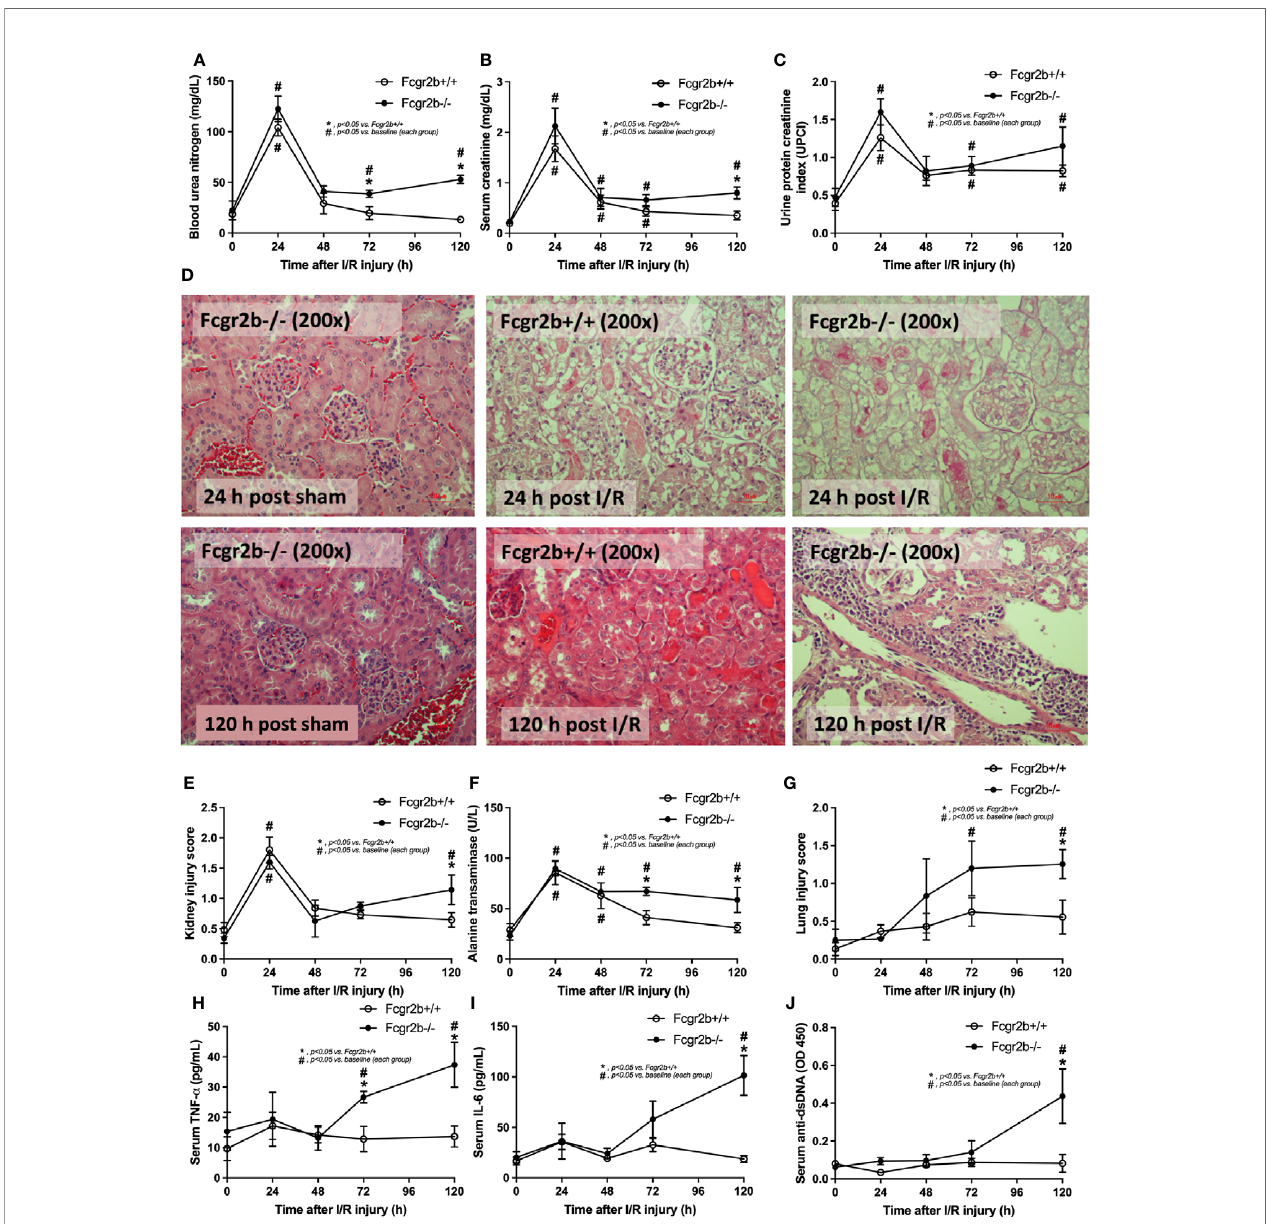
FIGURE 1 | Renal ischemia reperfusion injury (I/R) at 24 h induced lupus disease exacerbation at 120 h. The time-point characteristics of Fcgr2b-/- or wild-type (Fcgr2b+/+) mice after I/R as determined by i) renal injury; blood urea nitrogen (BUN), serum creatinine, and proteinuria (protein creatinine index; UPCI) along with the histological score of the representative images in Hematoxylin and Eosin (H&E) staining (original magni fi cation 200x) (A – E) , ii) liver injury (serum alanine transaminase) (F) , iii) lung injury score (G) , and iv) the parameters in serum; serum pro-in fl ammatory cytokines (TNF- a and IL-6) (H, I) and serum anti-dsDNA, a major auto-antibody in lupus (J) are demonstrated (n = 6 – 7/time-point). Notably, the renal histological pictures at 24 h post sham of Fcgr2b+/+ mice and at 120 h post sham (both mouse strains) are not demonstrated due to the similarity to Fcgr2b-/- mice at 24 h post sham (normal